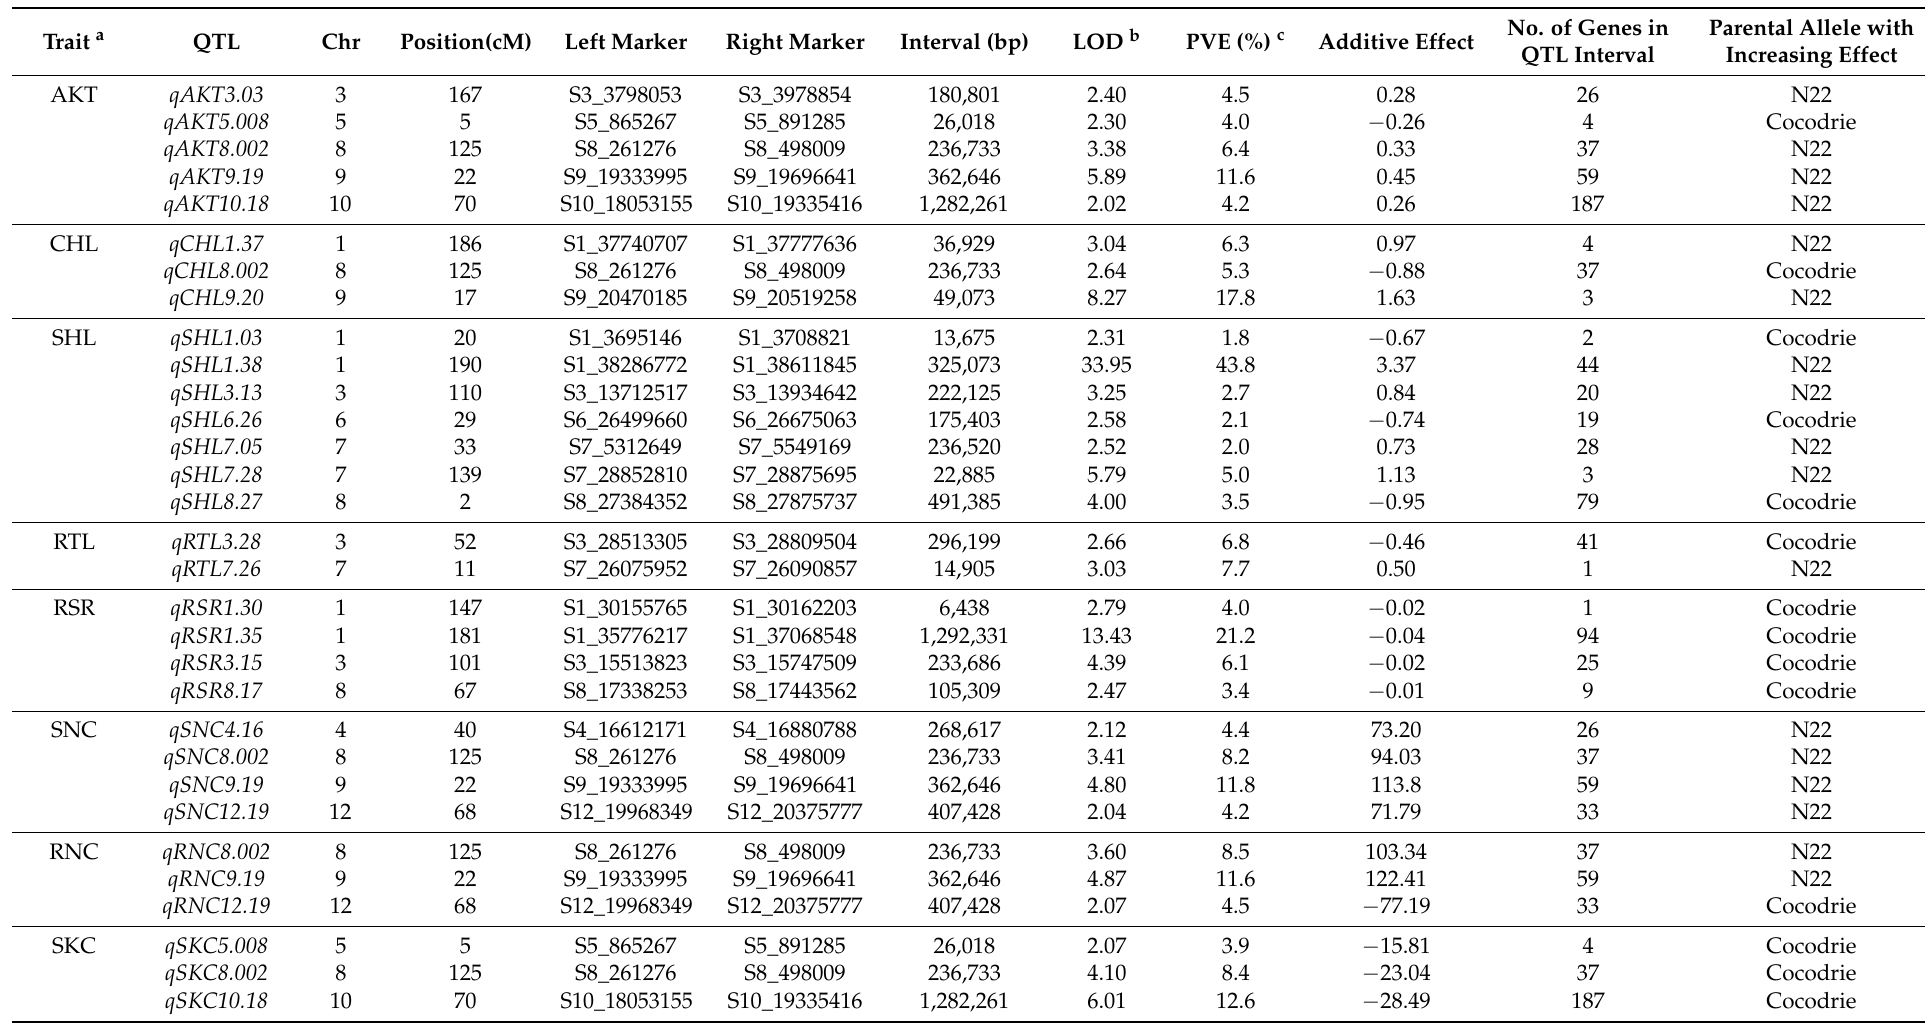
Table 3. List of additive QTLs for various morphological and physiological traits associated with alkaline stress at seedling stage of rice by ICIM